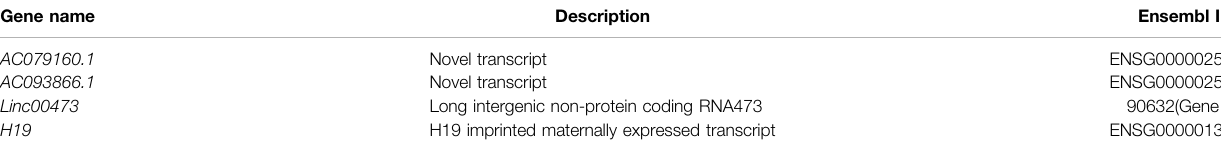
TABLE 1 | Potential genes signi fi cantly associated with gastric cancer prognosis.